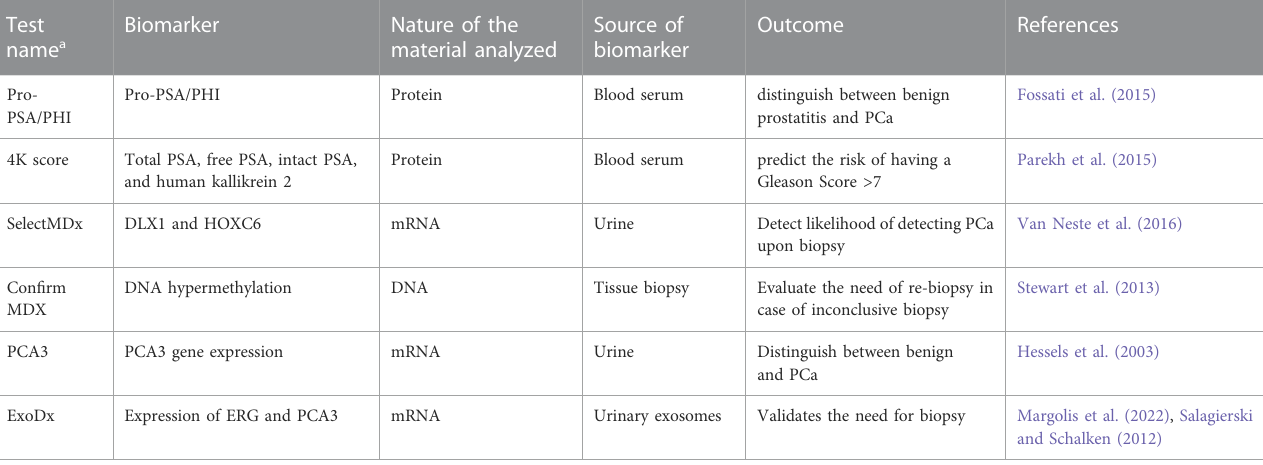
TABLE 1 List of commercially available clinical tests used for PCa diagnosis and con fi